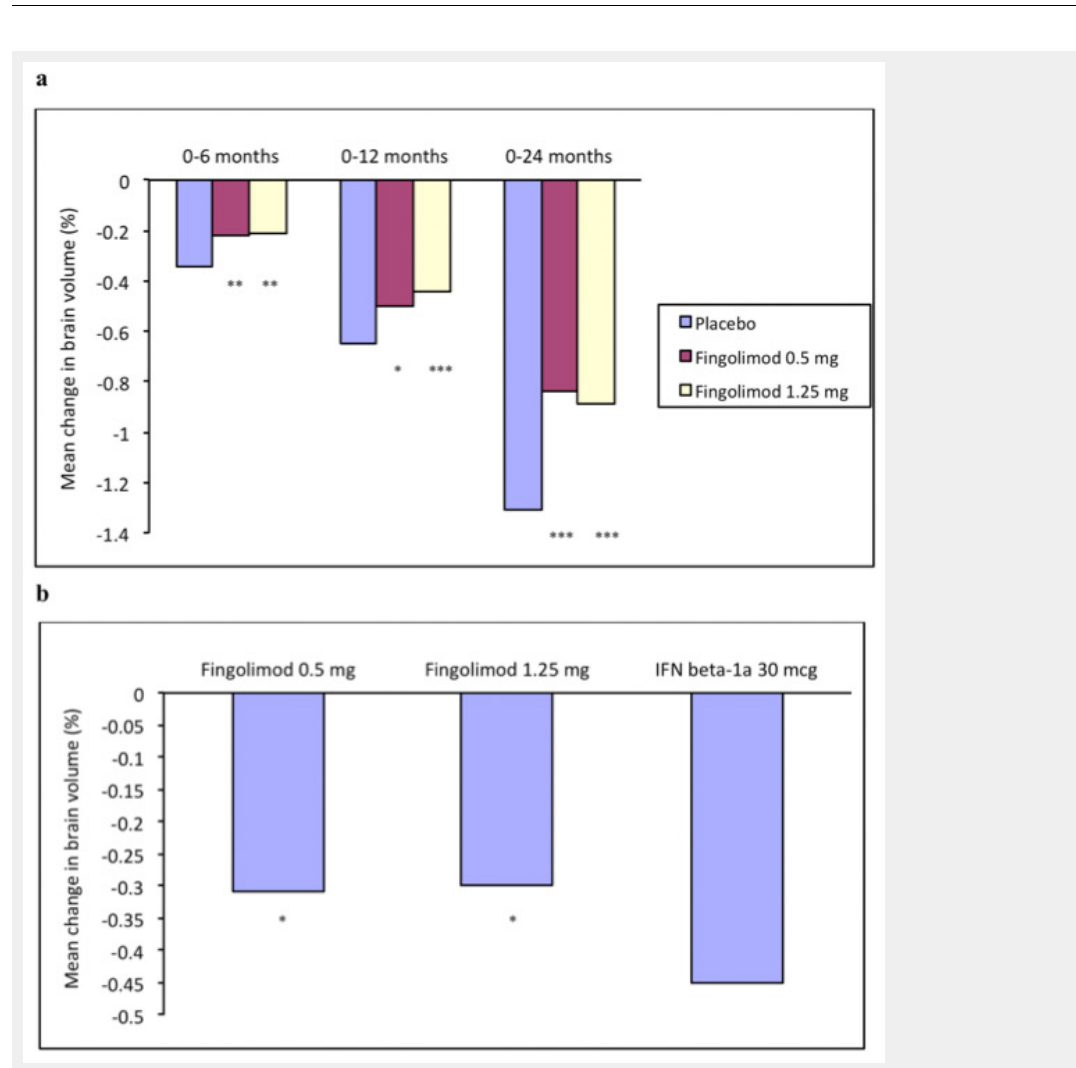
Figure 1 (a) Mean change in brain volume in patients with relapsing-remitting multiple sclerosis receiving oral treatment with fingolimod, 0.5 or 1.25 mg, or placebo once daily for 2 years in the FREEDOMS Study [11]. *,**,*** p ≤0.05, 0.01, 0.001, respectively, versus placebo (b) Mean change in brain volume over 1 year in relapsing-remitting multiple sclerosis patients receiving fingolimod, 0.5 or 1.25 mg daily or intramuscular IFNβ-1a 30 μg per week in the TRANSFORMS Study [12]. * p <0.001 versus